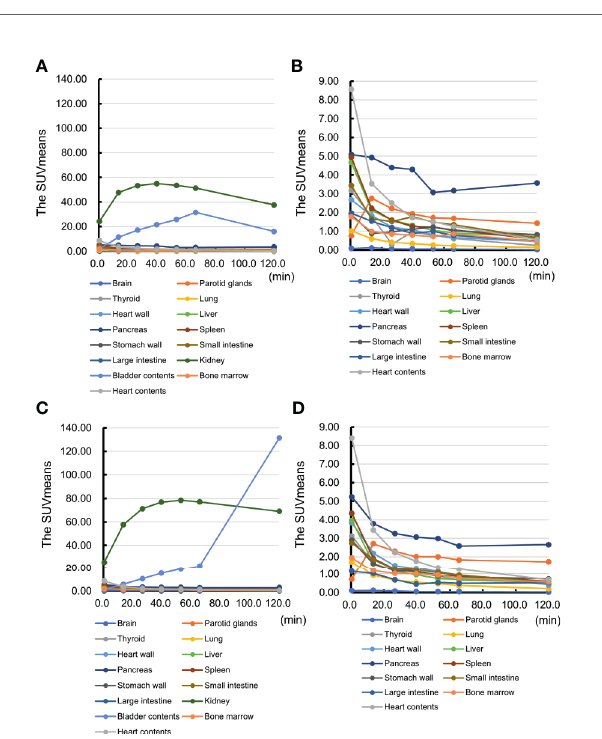
The time course of the mean standardized uptake value (SUVmean) in each organ of Case 2 and Case 3 is shown. Case 2: (A) the SUVmeans of all the organs and (B) the SUVmeans excluding kidney and bladder contents. Case 3: (C) the SUVmeans of all the organs and (D) the SUVmeans excluding kidney and bladder